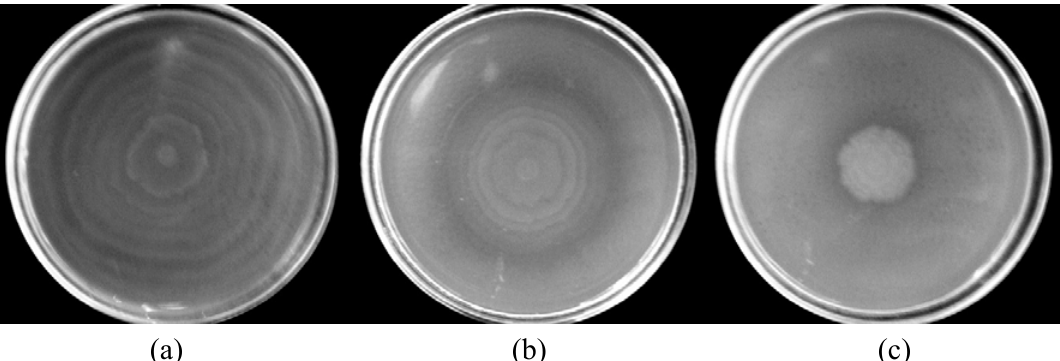
Figure 1 . Swarming of Proteus mirabilis L68 on LB swarming agar plates without terpenes (a), and with 0.5 mg/L of α -terpineol (b) and 0.3 mg/mL citronellol (c). Incubation period of 24 h at 37ºC.